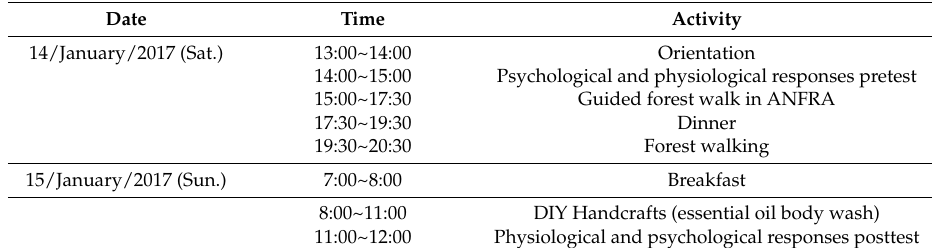
Table 1. Schedule of the field experiment. ANFRA: Aowanda National Forest Recreation Area; DIY: